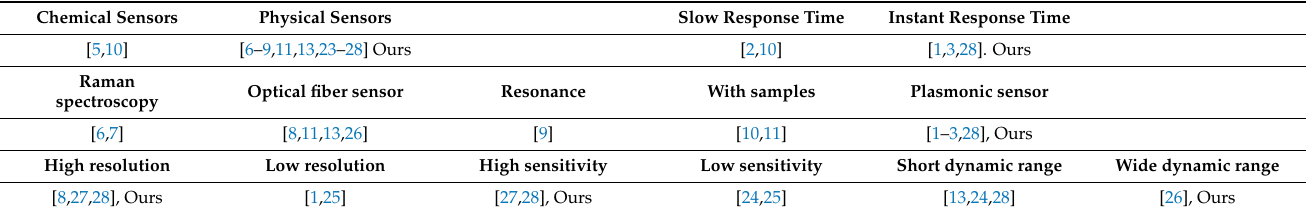
Table 1. Summary table with the essential characteristics of the sensors